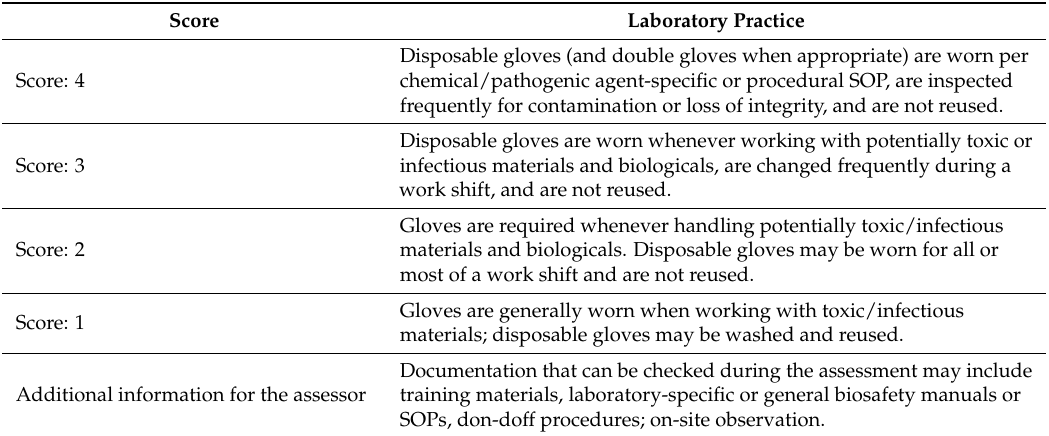
Table 2. Example of scoring options for the LMT-S subcategory question ‘Disposable glove usage’. Score Laboratory